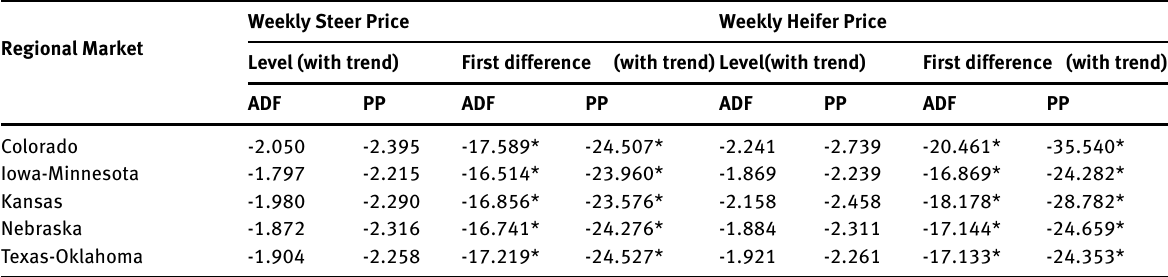
Regional Market